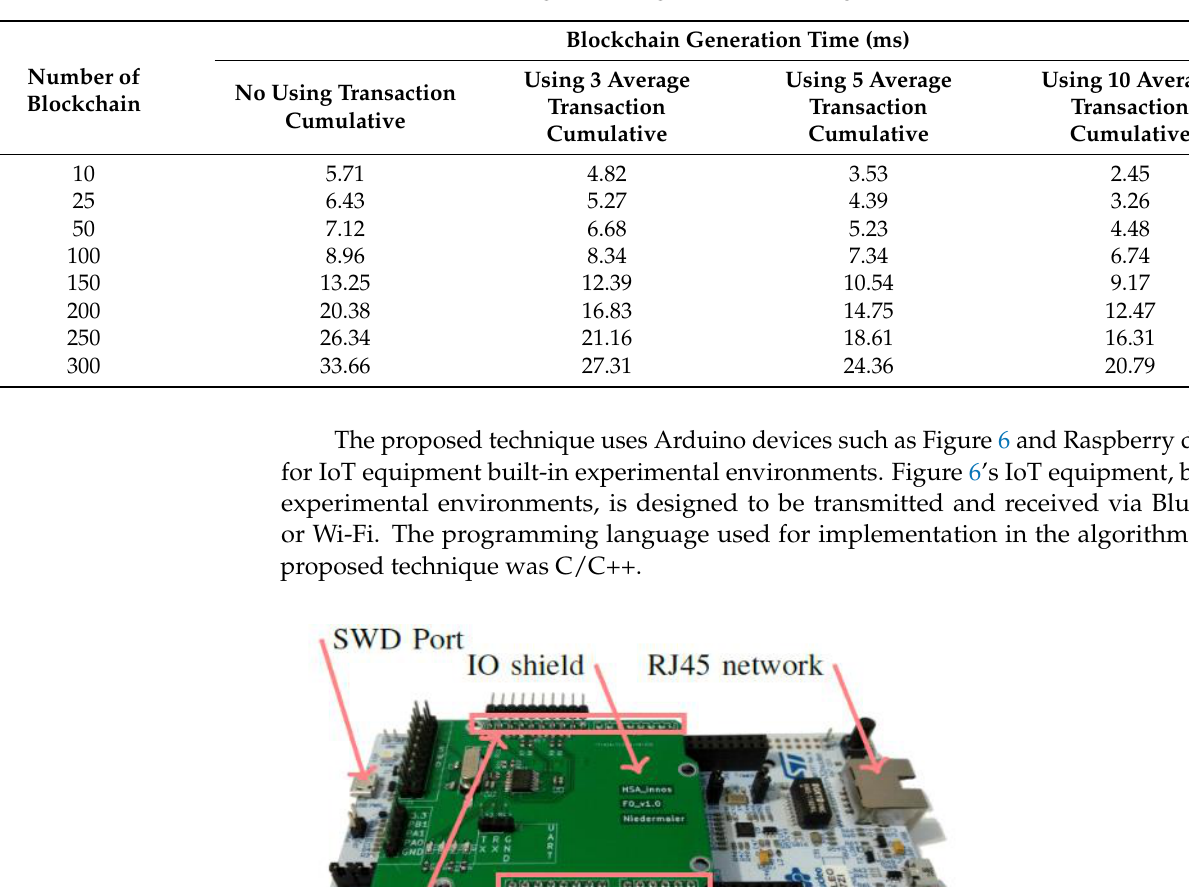
Table 4. Rate of change according to blockchain length.